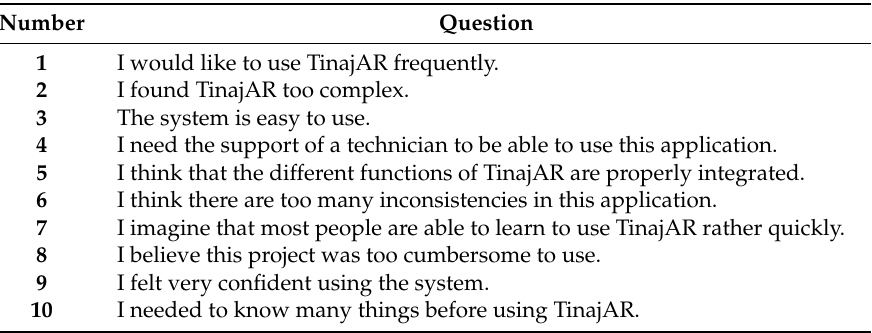
Table 1. The 10 questions of the SUS